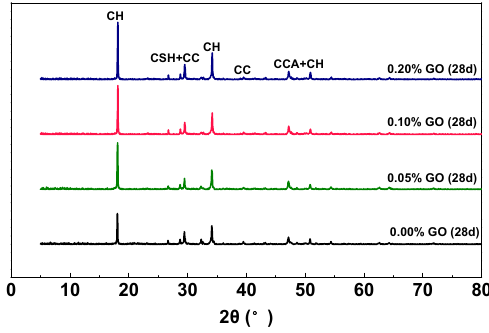
Figure 12. XRD patterns of different GO-cement composites at 28 days of curing. CH: Calcium hydroxide; C-S-H: Calcium silicate hydrate; CC: Calcium carbonate; CCA: Calcium carboaluminate hydrate.